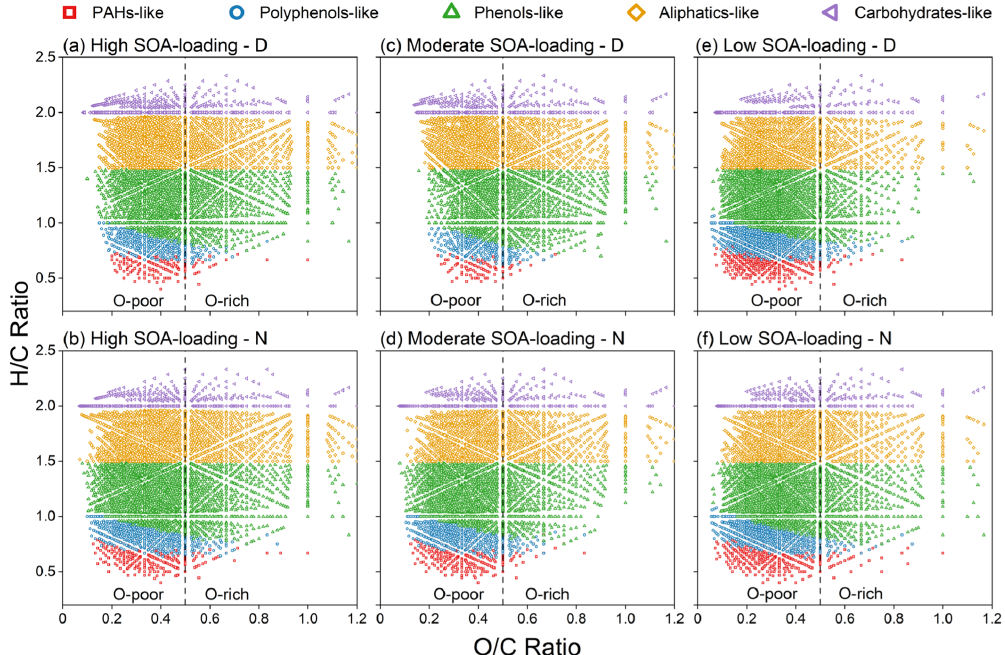
Figure 3. The van Krevelen diagrams of five compounds classes in each sample: (1) PAHs-like – polycyclic aromatic hydrocarbons, (2) Polyphenols-like – polyphenols and PAHs with aliphatic chains, (3) Phenols-like – highly unsaturated and phenolic compounds, (4) Aliphatics-like – unsaturated aliphatic compounds, (5) Carbohydrates-like – carbohydrate, saturated fatty and sulfonic acids. Note: oxygen-poor compounds (O / C ≤ 0 . 5), oxygen-rich compounds (O / C > 0 . 5).